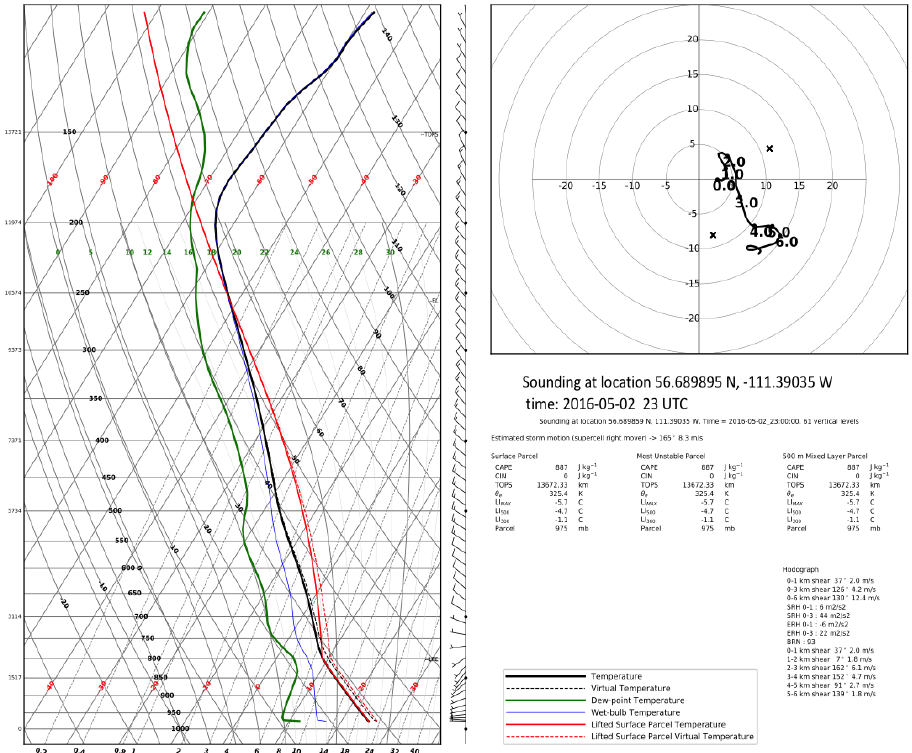
Figure 5. Model sounding and hodograph at the location 56.689895 N, 111.39035 W. The convective available potential energy (CAPE) reached 887 J/kg with no convection inhibition (CIN). The mean wind determined the speed and direction of the main pyroconvection cell at 23:00 UTC on May 2. The solid black line in Skew-T is the ambient air temperature, the solid green line is the dew-point temperature and the solid red line is the lifted surface parcel temperature.